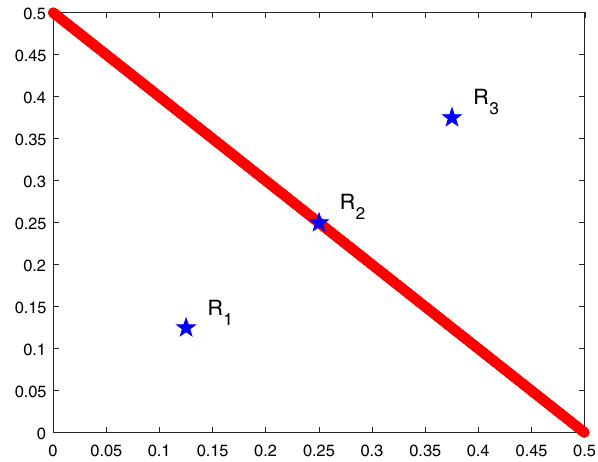
Fig. 6 Different reference points in the objective space of